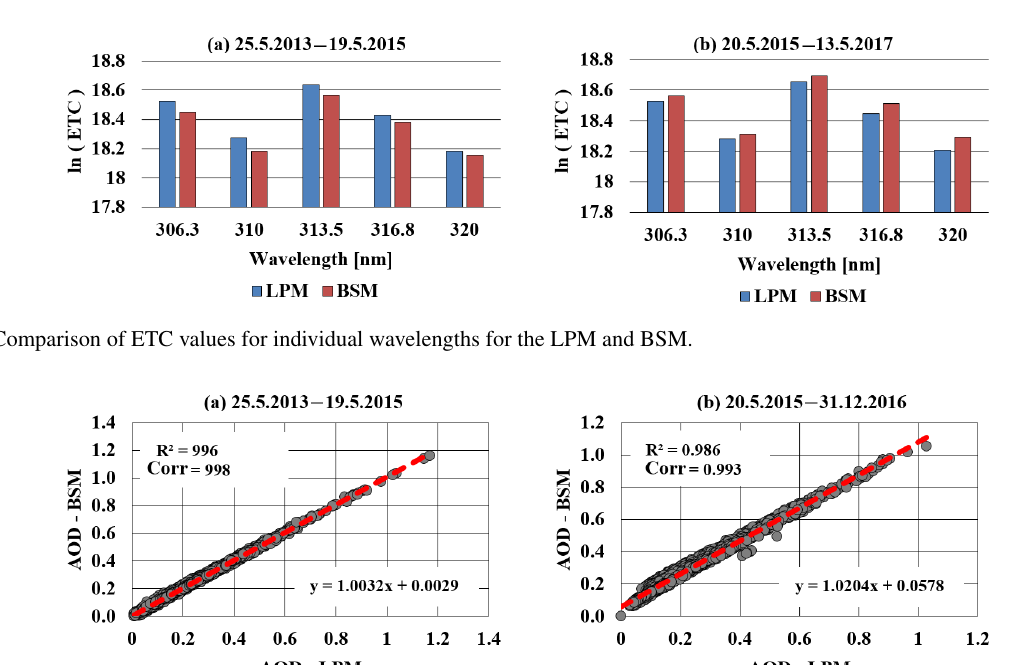
ETCs between the given two periods. The decrease for the BSM was more